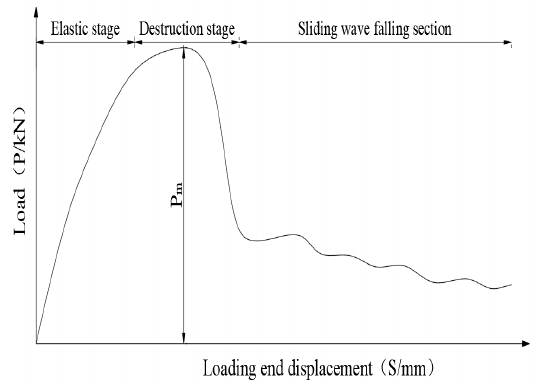
Figure 10. Load-displacement curve.